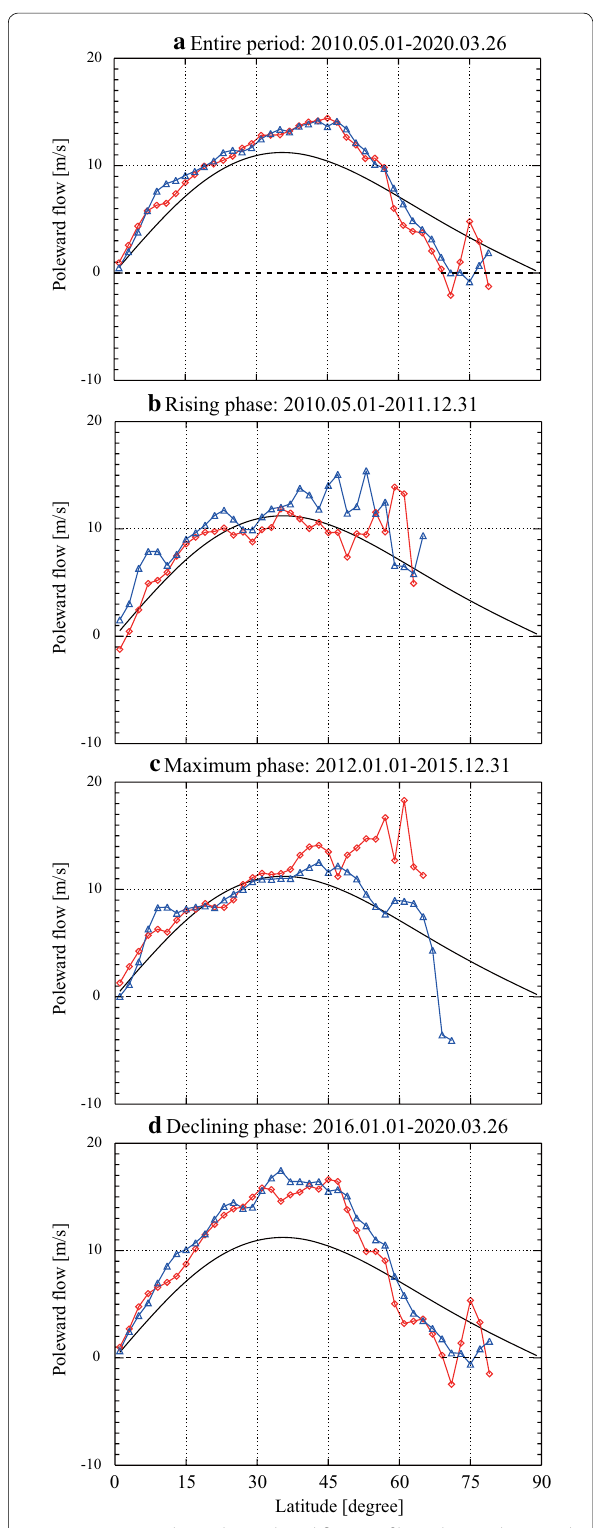
Fig. 4 Average poleward meridional flow profile in the northern (red) and southern (blue) hemispheres a during the entire period, b rising, c maximum, and d declining phases of solar cycle